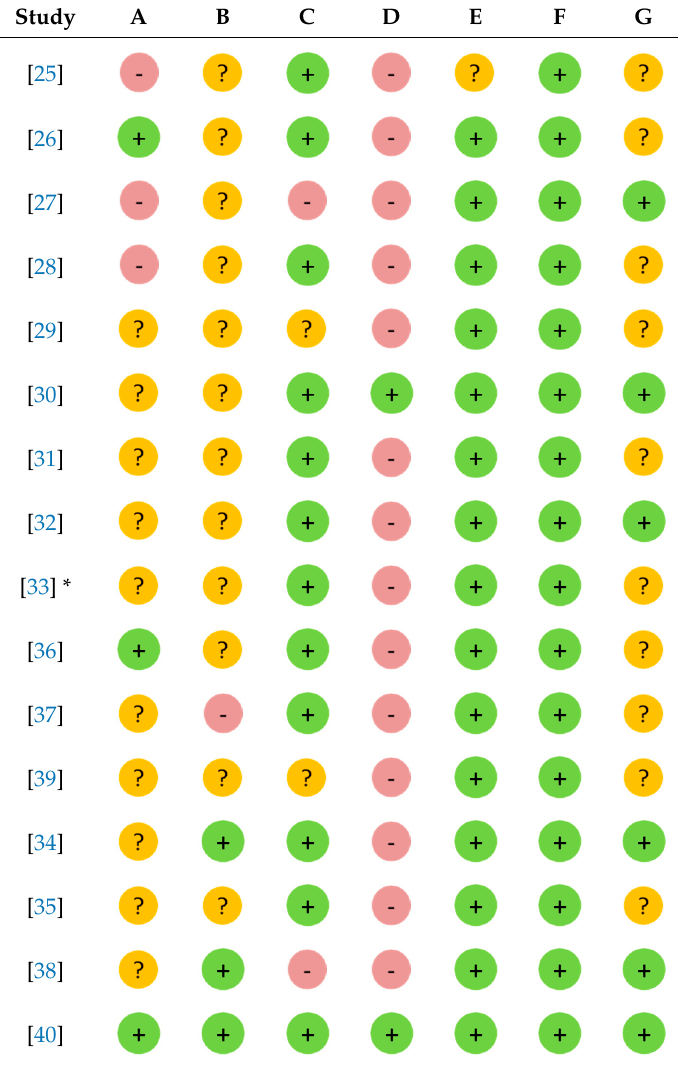
Table 4. Quality assessment of the included studies. Cross-over studies where A = Randomized treatment order; B = Carry-over e ff ect; C = Performance bias; D = Detection bias; E = Attrition bias; F = Reporting bias; G = Other bias. * Parallel studies where A = Random sequence generation and B = Allocation